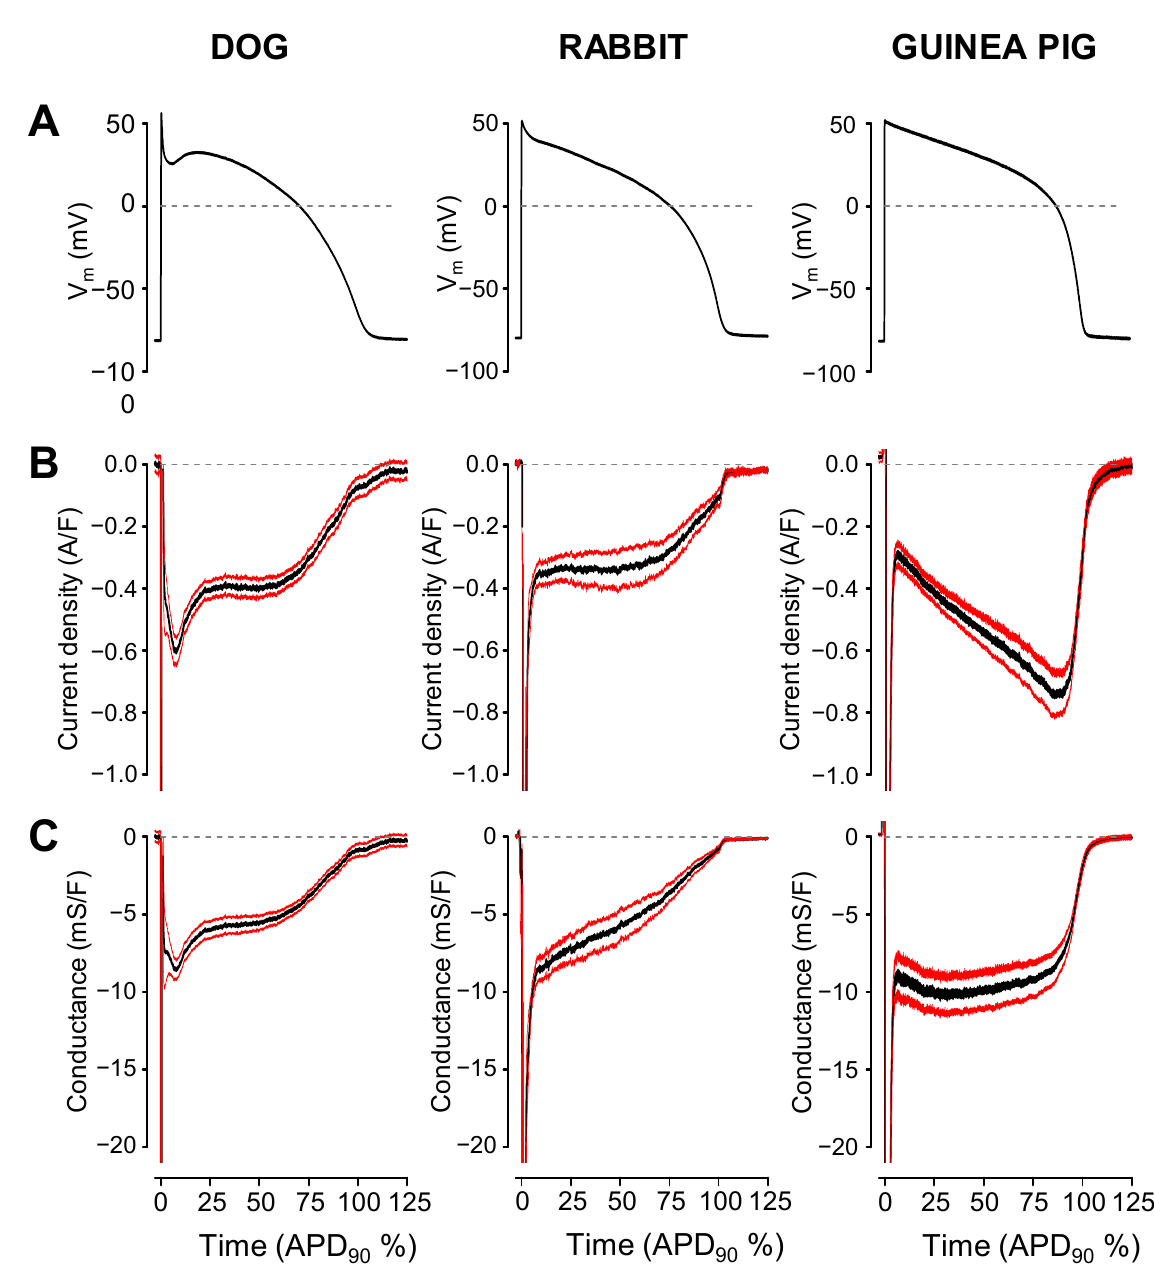
Figure 2. Average I Na,late ( B ) and G Na,late ( C ) profiles recorded under self APVC conditions from 15 canine, six rabbit, and 18 guinea pig ventricular myocytes. Black lines are the mean data, while red ones represent the SEM values. For the sake of comparability, the I Na,late and G Na,late values were averaged according to their positions on the time axis, where the action potential duration measured at 90% repolarization (APD 90 ) was considered as 100%. Representative command APs are shown in the top row ( A ).